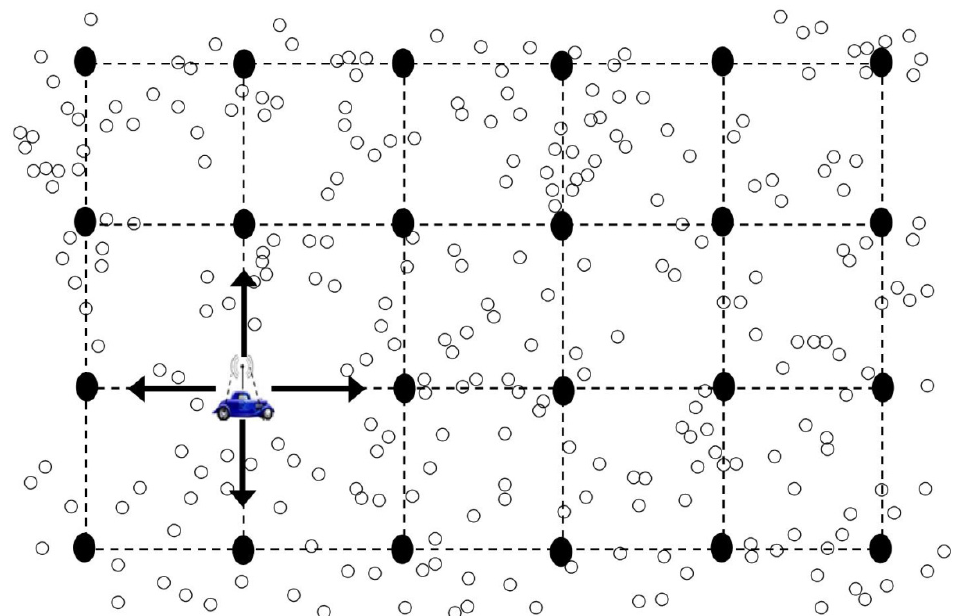
Figure 12. Example of overlay graph G